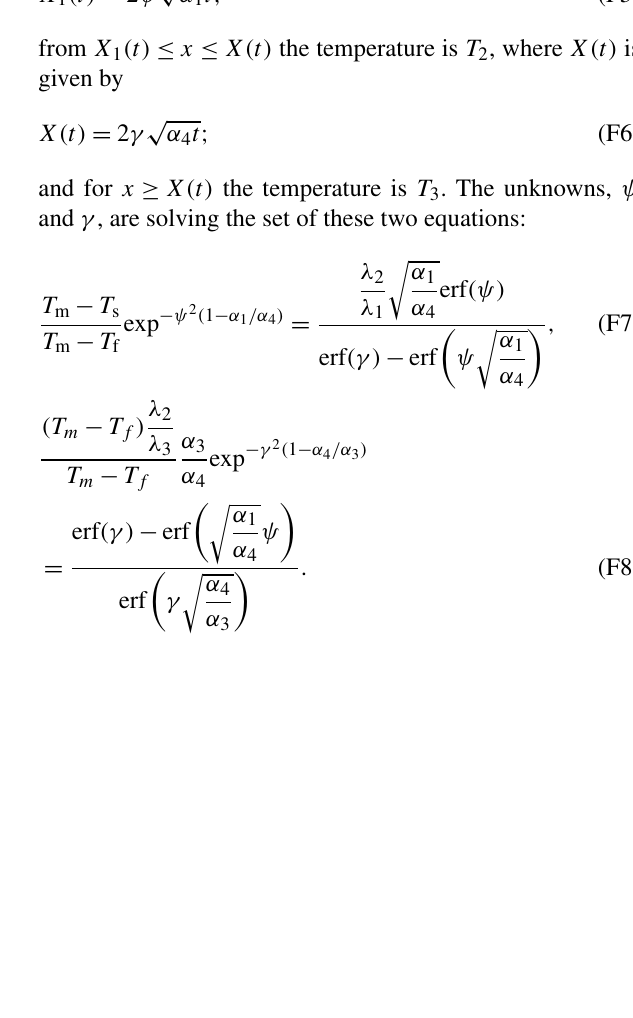
Table E1. Input parameters for the comparison between Neumann analytical solution and the numerical solution with the NCZ algorithm. Symbol Parameter Value Unit (cid:49)t time step 60, 300, 3600 s (cid:49)z control volume size 0 . 001, 0 . 005, 0 . 01 m l f latent heat of fusion 333700 Jkg − 1 c w specific heat capacity of water 4187 c i specific heat capacity of ice 2108 Jm − 3 ◦ C − 1 ρ w water density 1000 thermal conductivity of water 0 . 6 thermal conductivity of ice melting temperature range